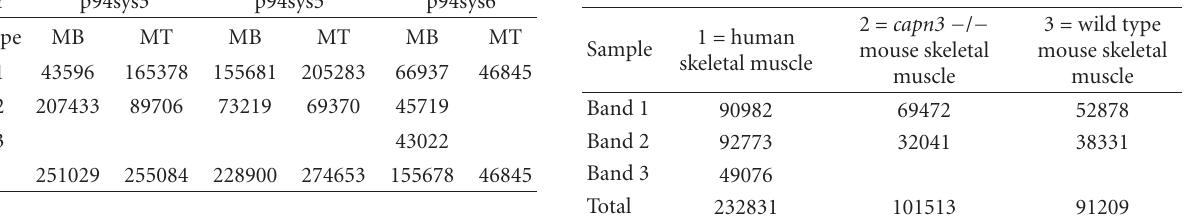
Table 2: Western blot quantification: cleavage of the ryanodine receptor in wild type and calpain 3-deficient skeletal